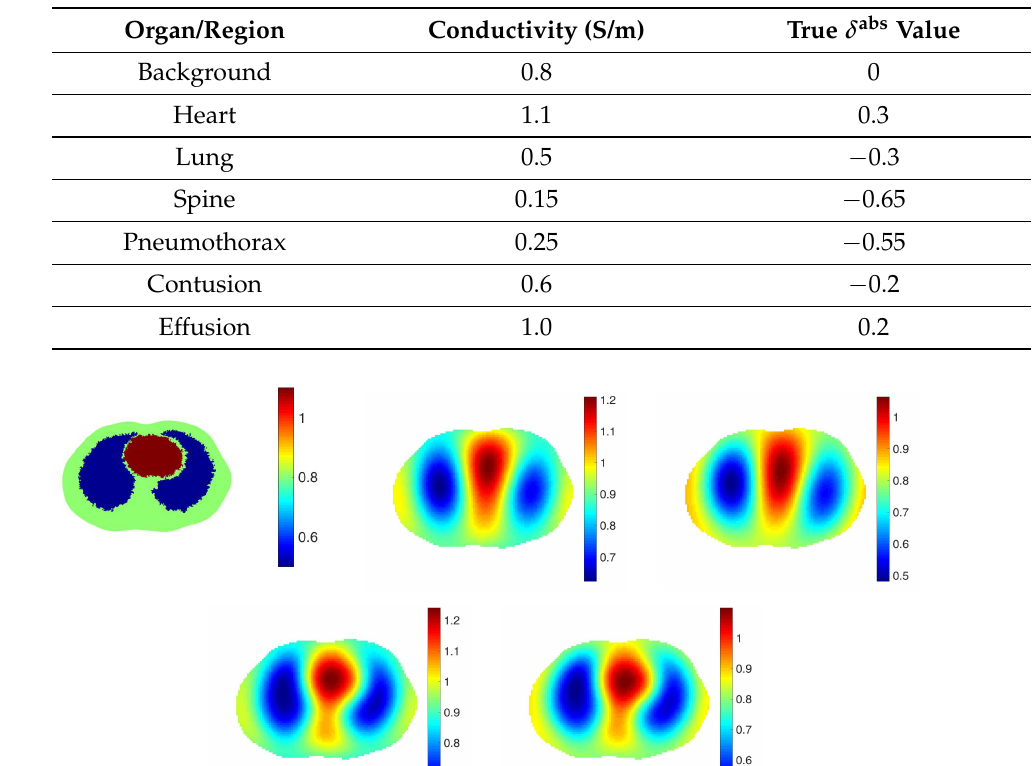
Table 1. Conductivity values for the simulated data by organ.